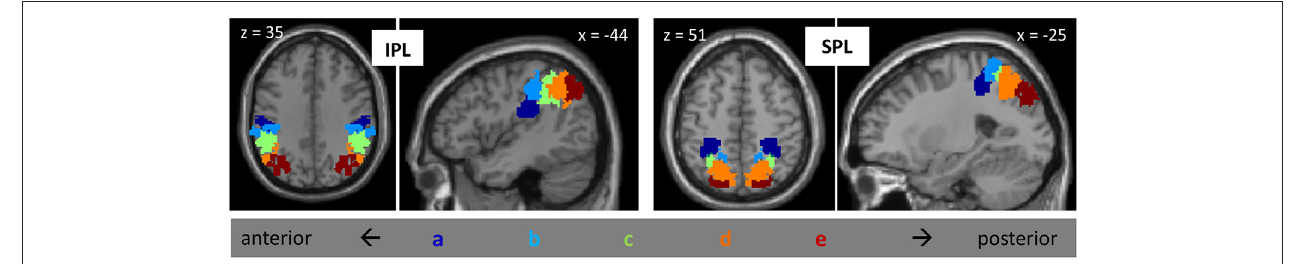
FIGURE 1 | Posterior parietal ROIs from Mars et al., 2011, including five subdivisions of IPL and five subdivisions of SPL, on the left and on the right . Subdivisions are labeled “a” through “e”, from anterior to posterior.